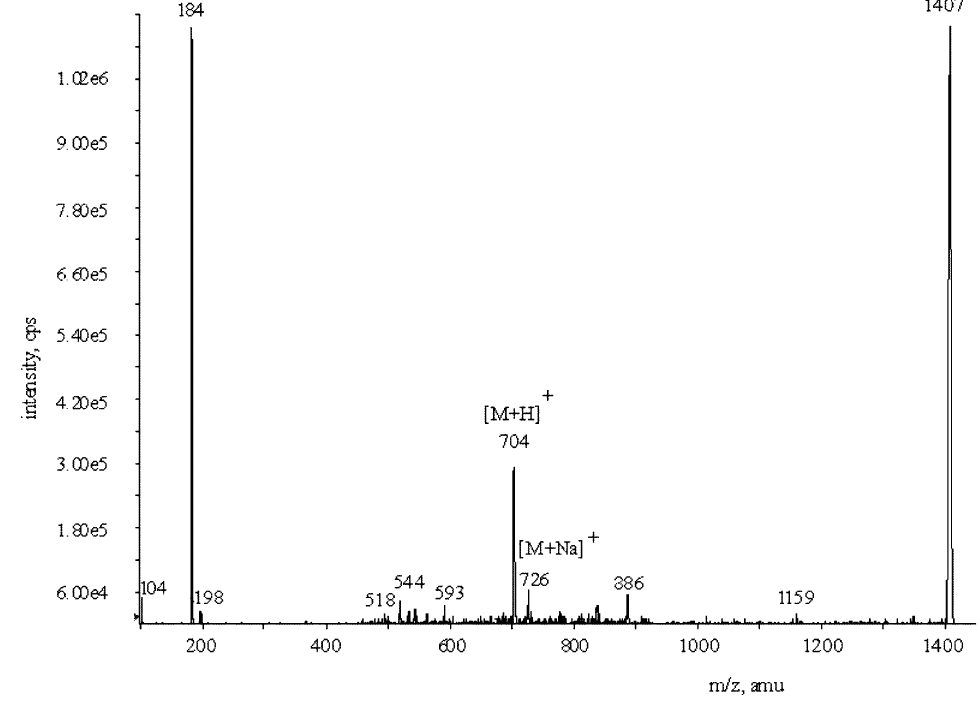
FIG. 6. Positive ion electrospray MS/MS spectrum of the ion at m/z1407.